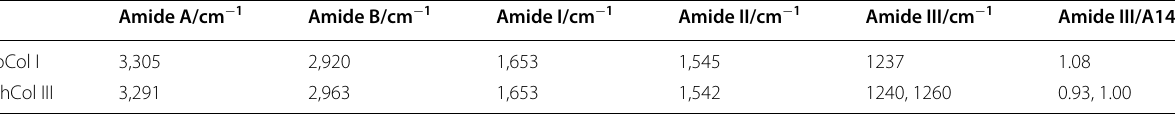
Table 4 FTIR spectra characteristic peaks of bCol I and rhCol III